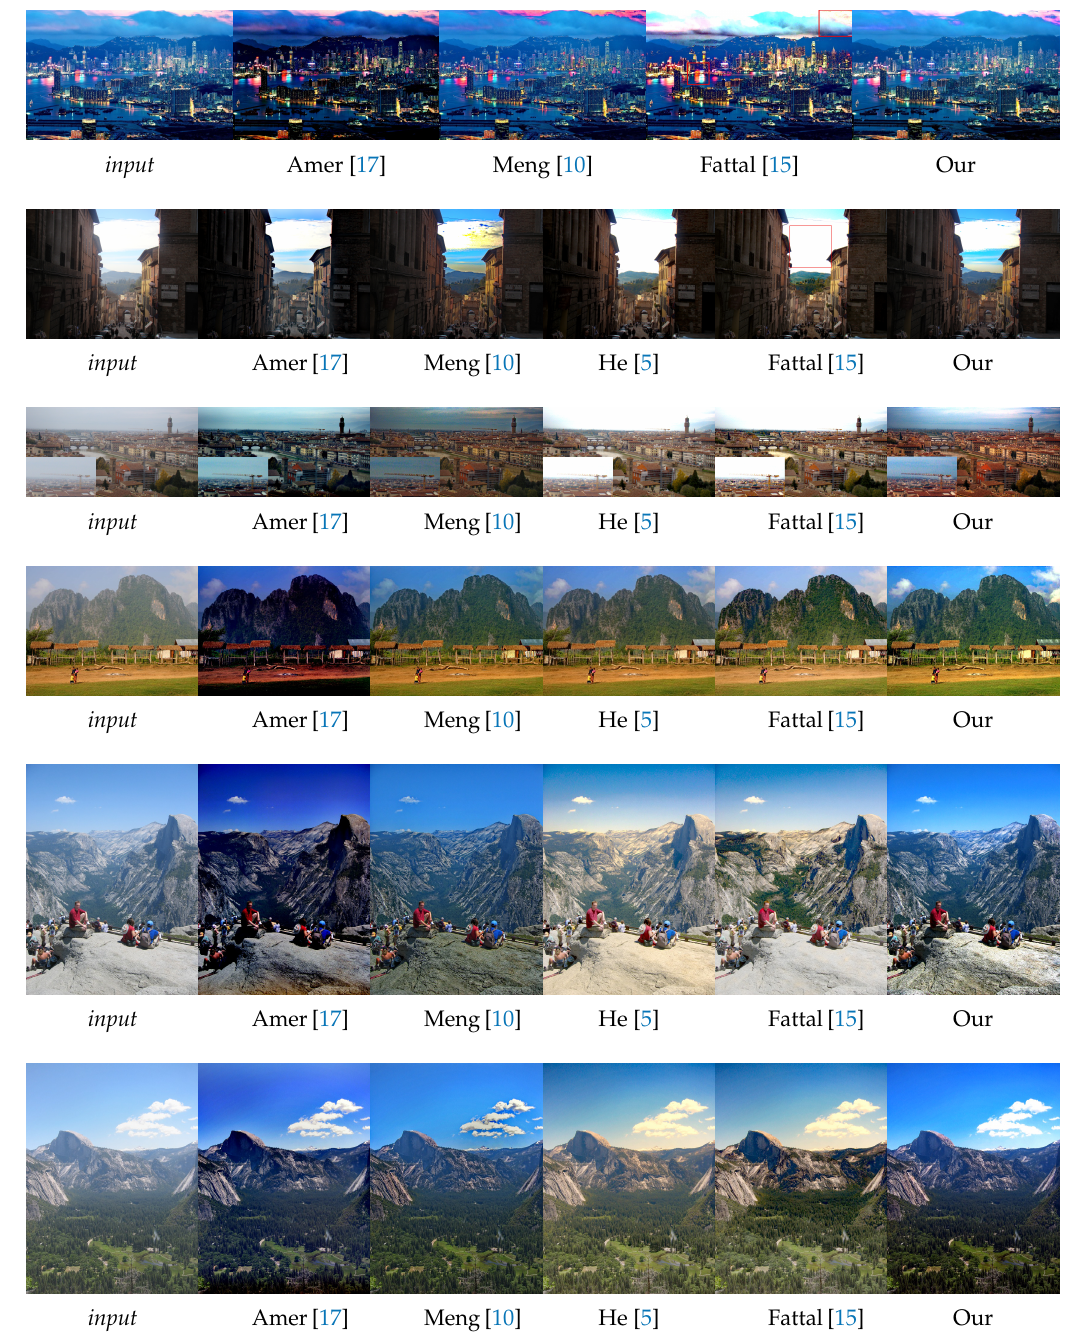
Figure 10. Qualitative results on images with both sky and clouds. Red boxes indicate dehazing